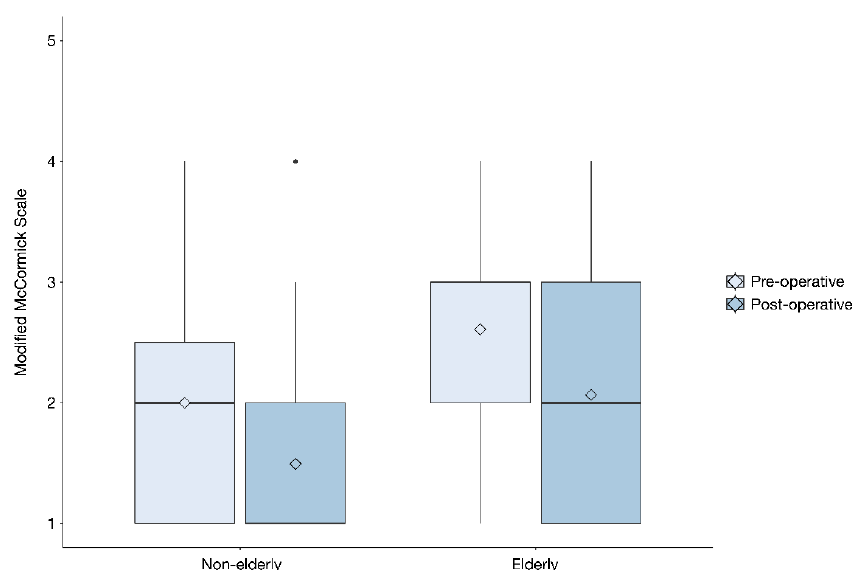
Figure 4. Box plot depicting pre- and postoperative modified McCormick scale for the elderly and non-elderly cohort. The dot represents an outlier.